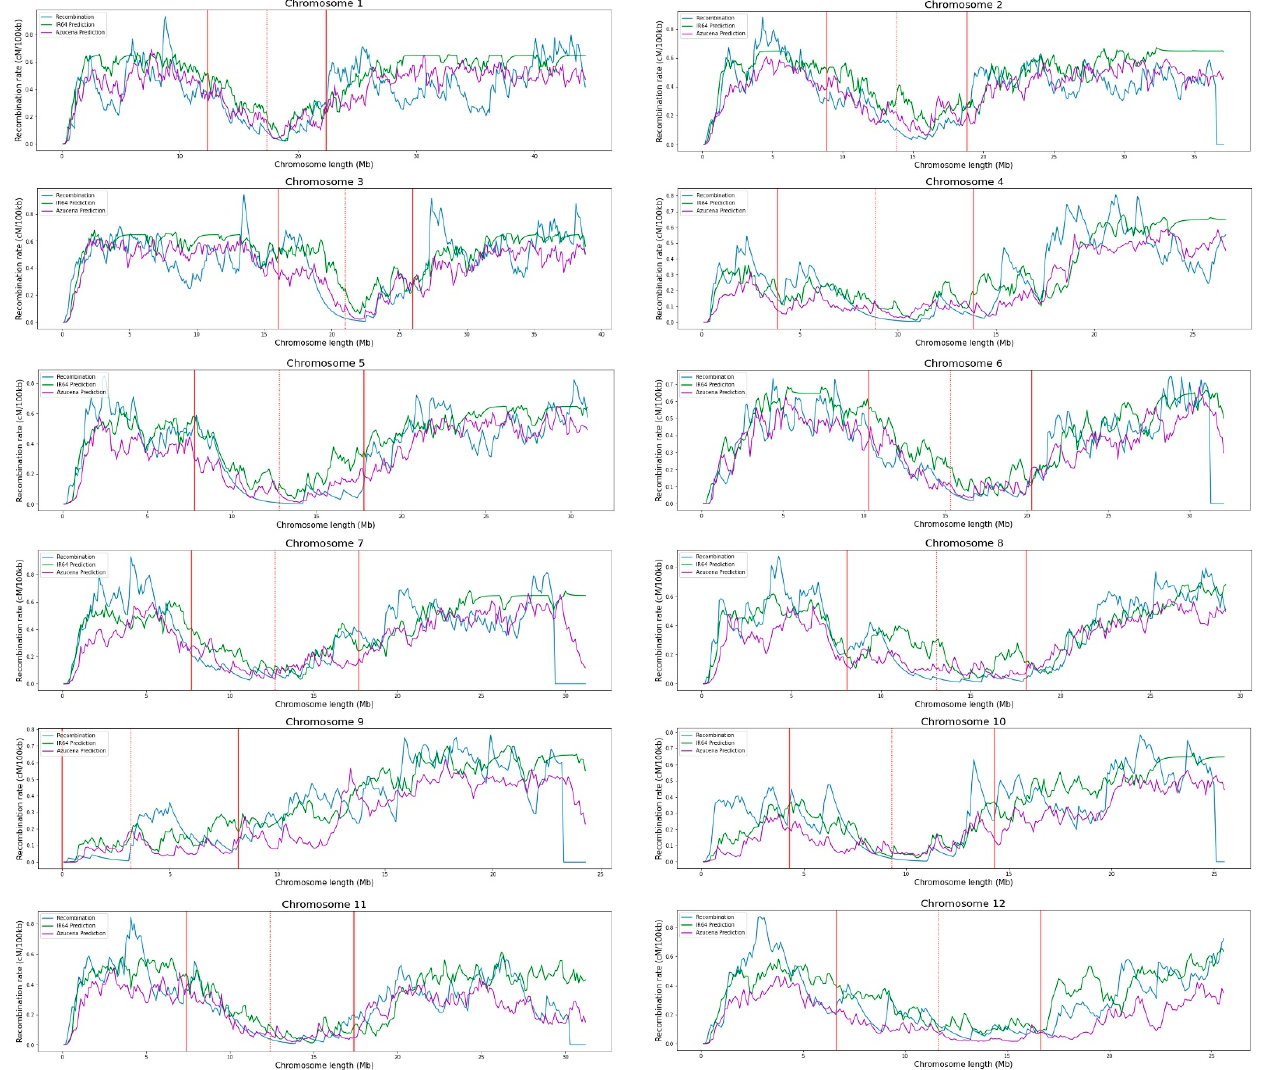
Figure 8. Recombination predictions between IR64 and Azucena varieties by the Extra Trees machine learning model using the count of methylated cytosines in the CHH context as a feature. Predictions on the IR64 manifold are made using Azucena methylation as the training dataset, and predictions on the Azucena manifold are made using IR64 methylation as the training dataset. The centromere is represented by a red dotted line and the influence of the centromere region in recombination by solid red lines.